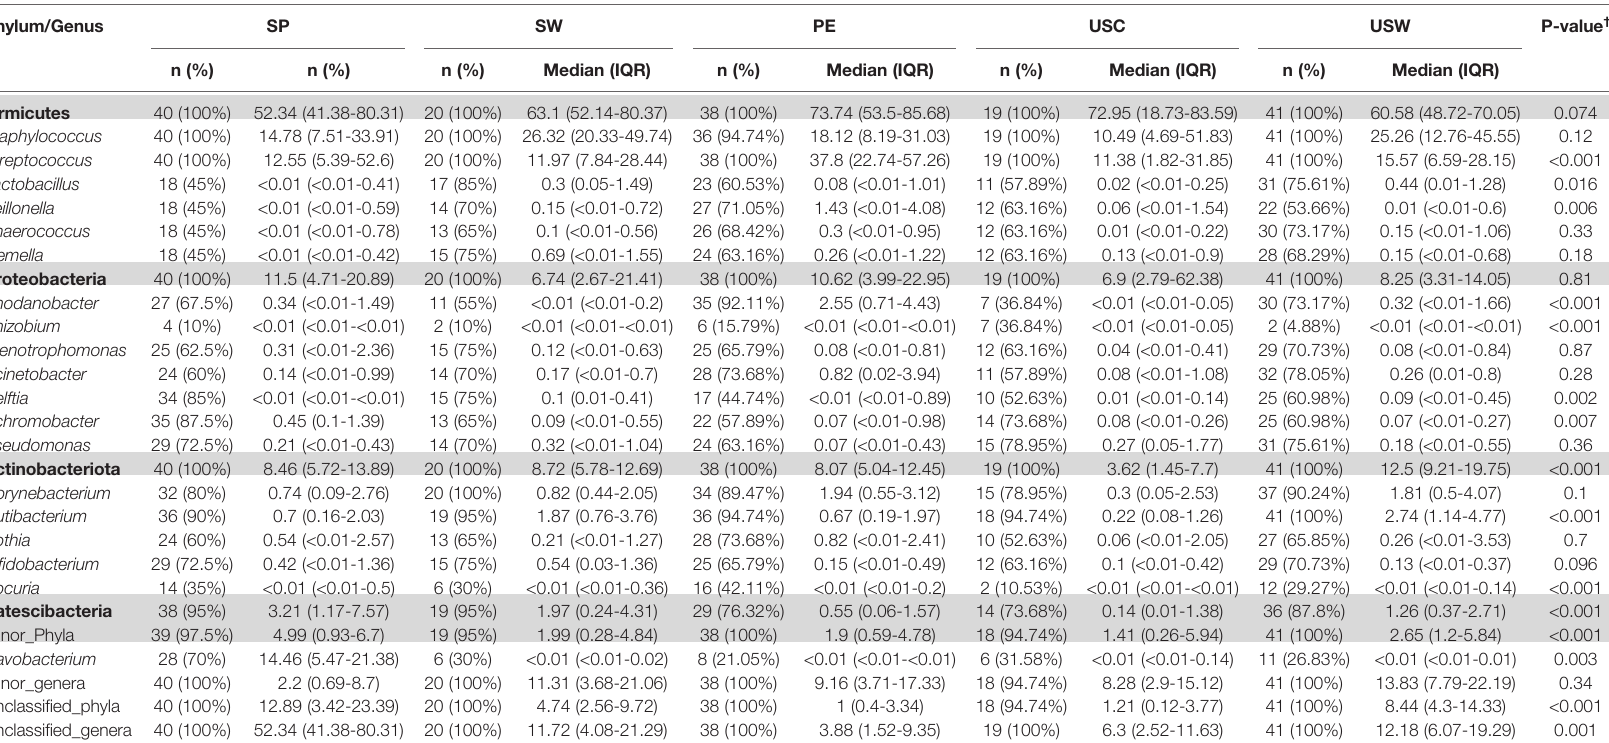
TABLE 4 | Relative frequencies, medians and interquartile range (IQR) of the most abundant bacterial phyla (bold) and genera detected in milk samples from European and American cohorts.